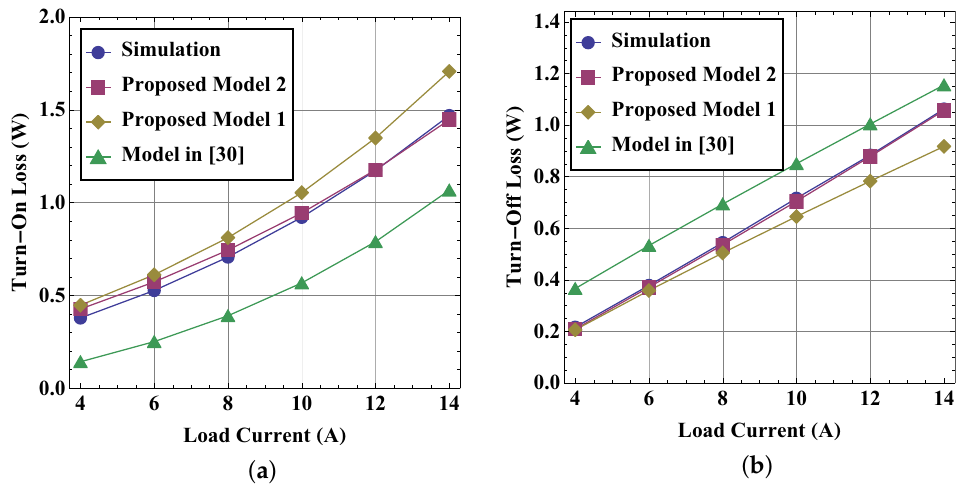
Figure 9. Switching loss of the models based on [30] at 10 MHz, 10 V input voltage, and 5 V gate driving voltage: ( a ) turn-on loss as a function of load current; ( b ) turn-off loss as a function of load current.